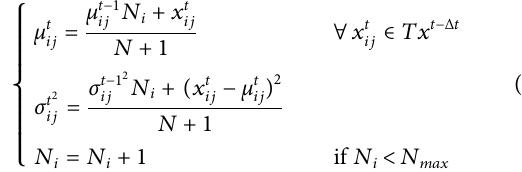
Frontiers in Robotics and AI |